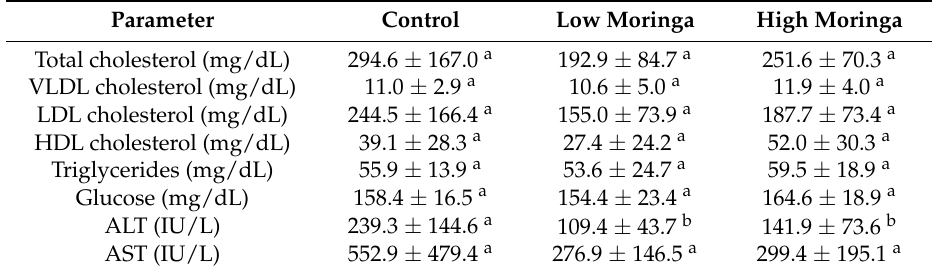
Table 1. Plasma Lipid profile, glucose, insulin and liver enzymes of guinea pigs fed a hypercholesterolemic diet with no Moringa (control), Low (10%), or High Moringa (15%) 1 .